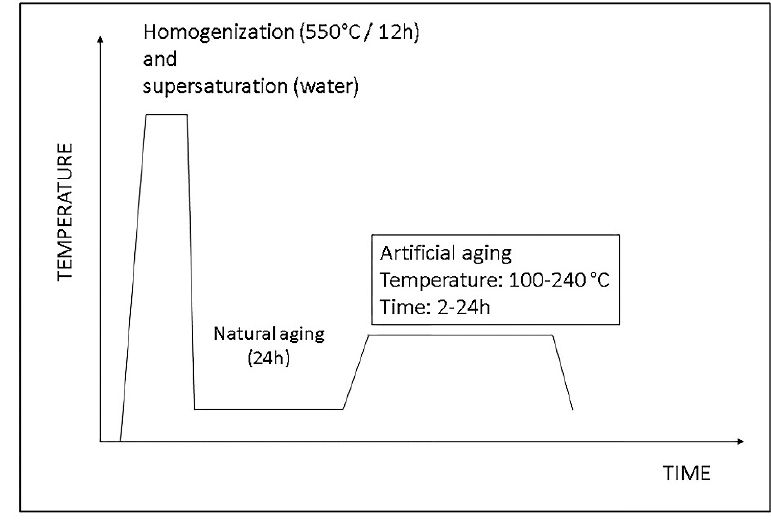
Figure 2. Scheme of the heat treatment of the wire rods.